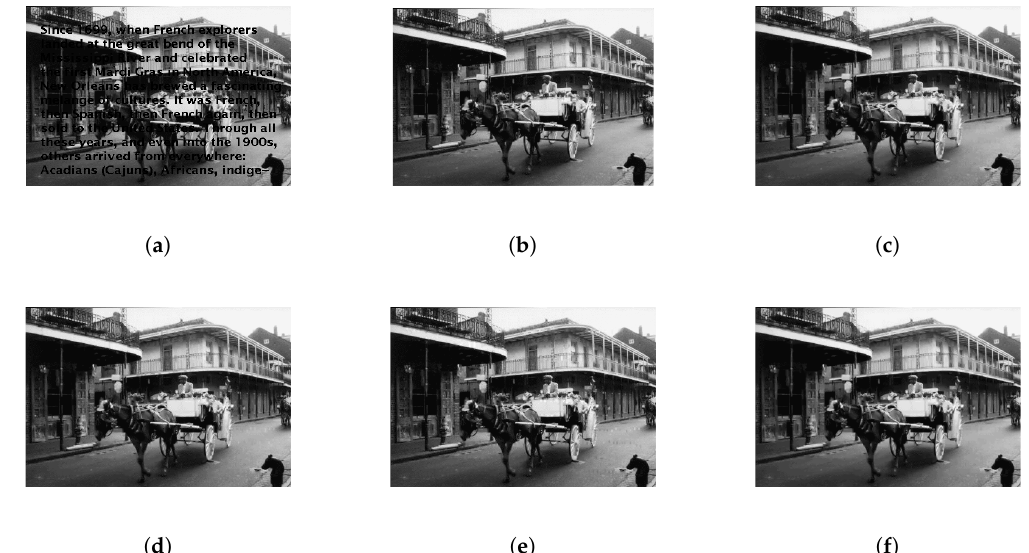
Figure 6. Restoration results of different algorithms under a specific data missing pattern. ( a ) corrupted image with 21.4% specific missing; ( b ) reconstructed image obtained by framelet+APG; ( c ) reconstructed image obtained by framelet+ADMM; ( d ) reconstructed image obtained by wavelet+APG; ( e ) reconstructed image obtained by wavelet+ADMM; ( f ) reconstructed image obtained by FoE.